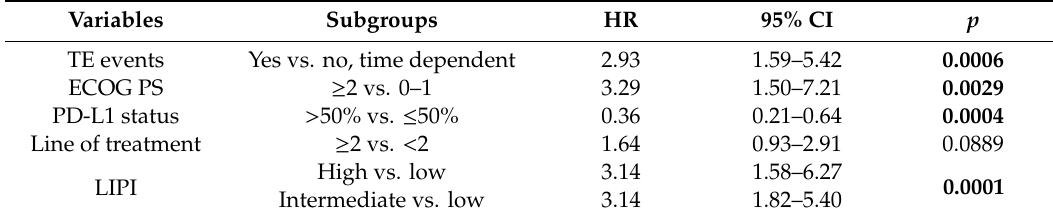
Table 6. Multivariate Cox proportional hazards models for overall survival.